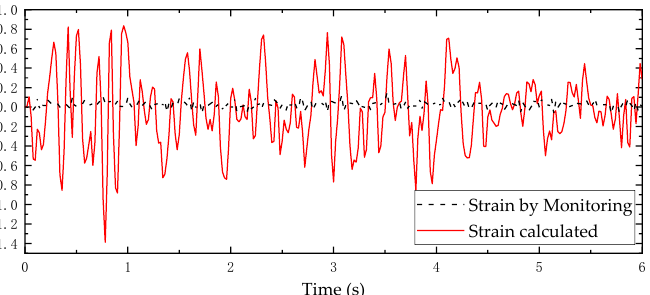
Figure 19. Comparison of dynamic strain between measurement and simulation results of DSS-12.